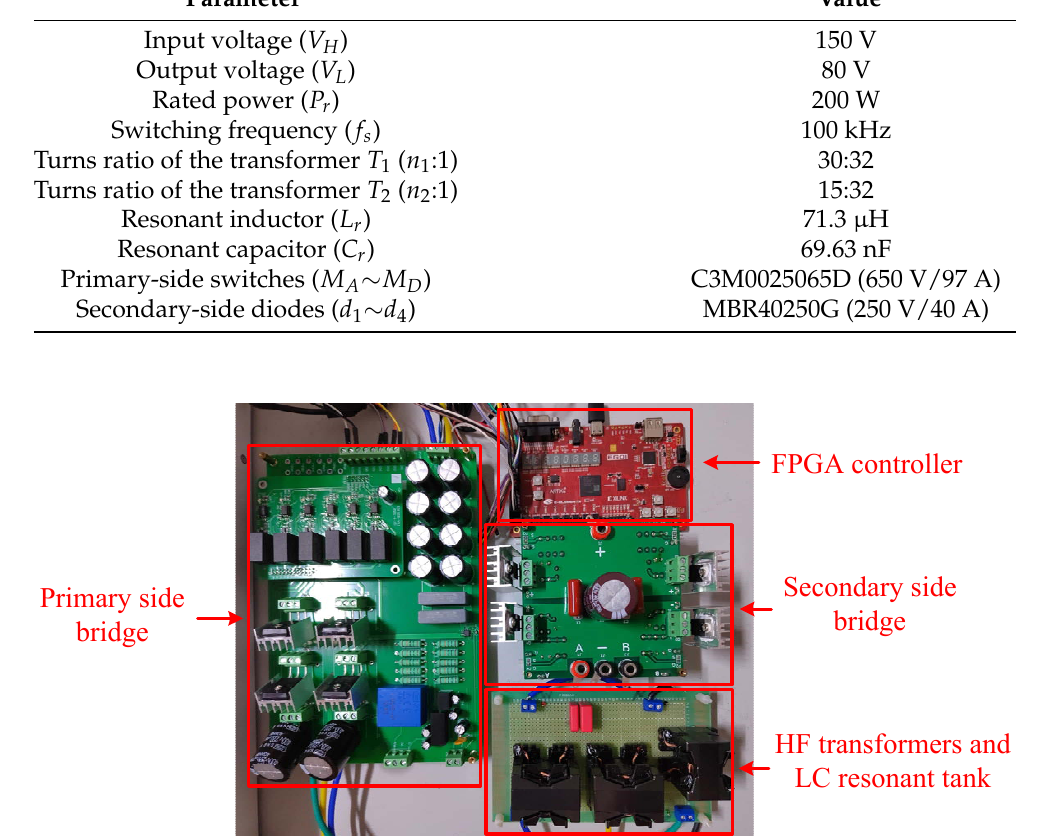
Figure 11. The experimental prototype of the proposed